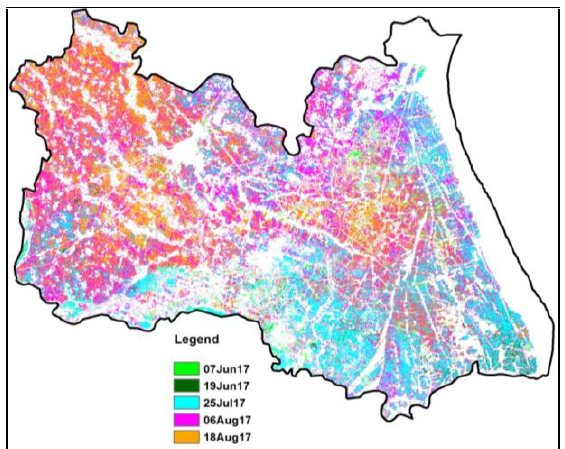
Figure.5. Staggering of the rice crop transplantation mapped from Senrinel-1A SAR